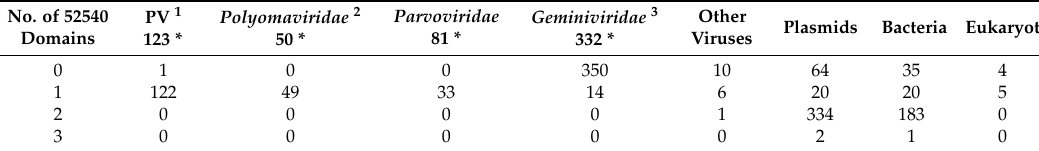
Table 4. Number of sequences containing SF_55464 with different domain